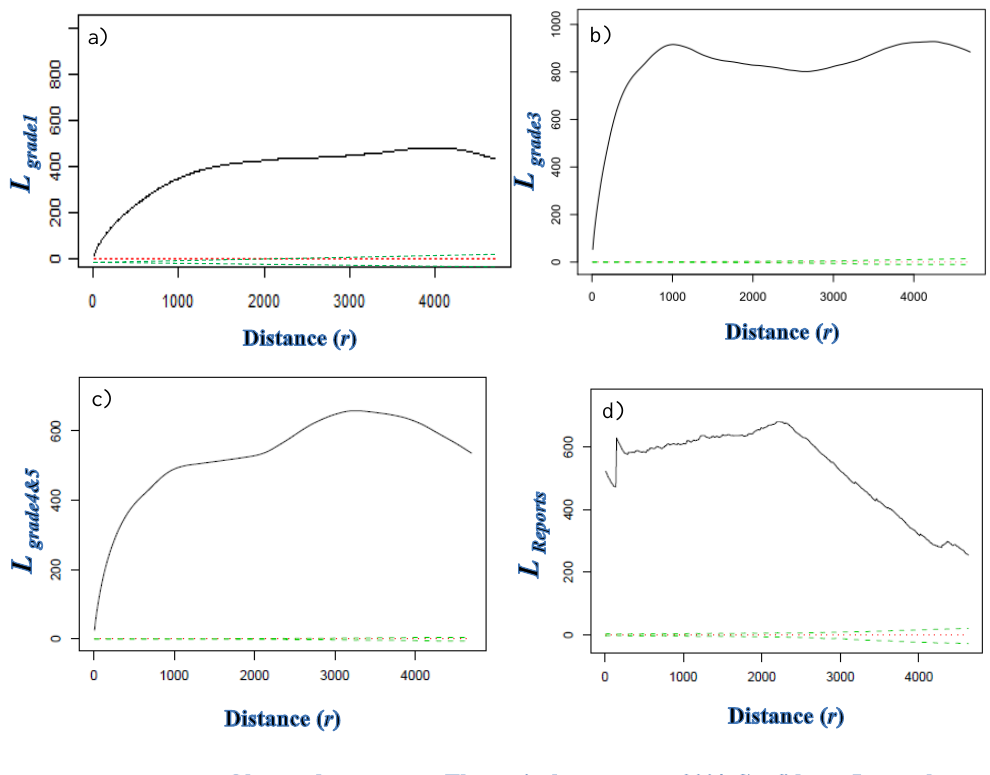
Figure 4. Self functions L with i = building damage grade 1 (a); i = building damage grade 3 31 Fig. 4. Self functions L ii with i = building damage grade 1 (a) ; i = building damage grade 3 (b) ; i = building damage grades 4 and 5 (c) ii (b); i = building damage grade 4 and 5 (c) and i = crisis reports (d), with envelopes computed 32 and i = crisis reports (d) , with envelopes computed under the hypothesis of independence of under the hypothesis of independence of populations. 33